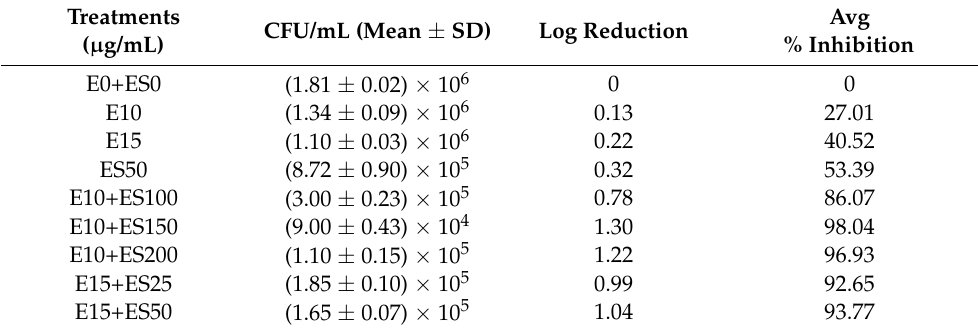
Table 1. Colony-forming units (CFU/mL) and respective log reduction and percentage of inhibition for different treatments on biofilm formation in E. coli . E: erythromycin; ES: epigallocatechin-3-gallate- stearate